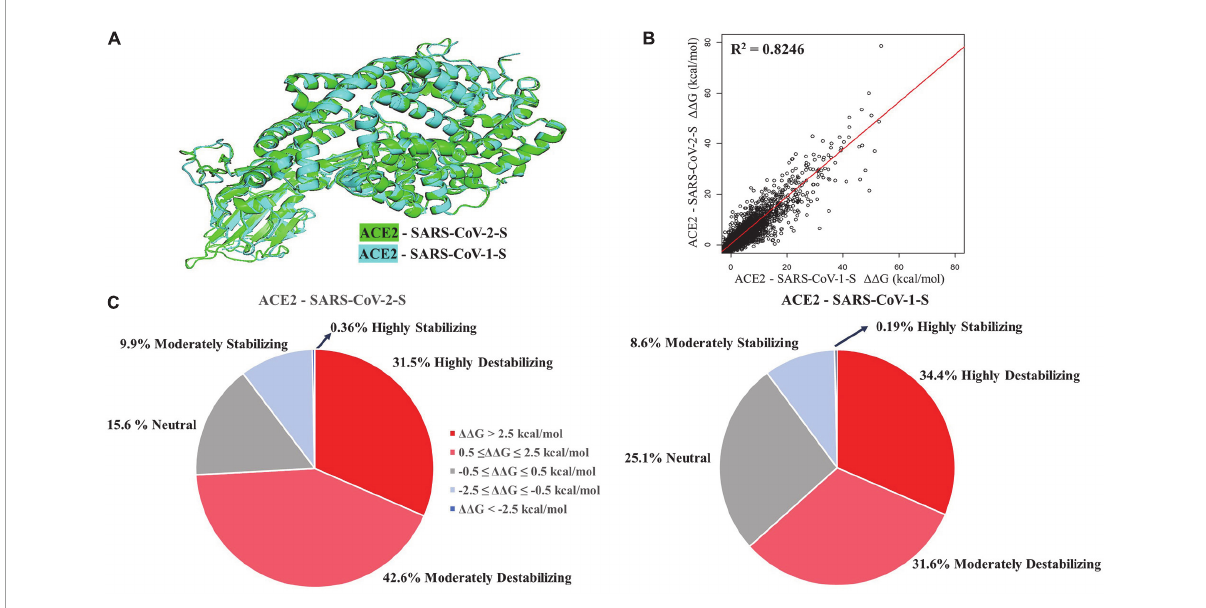
FIGURE1 Structural alignment (A) and regression analysis (B) of ACE2 - SARS-CoV-2-S and ACE2 - SARS-CoV-1-S complexes. Pie charts (C) displaying the distribution of effects of mutations on protein stability effects of missense